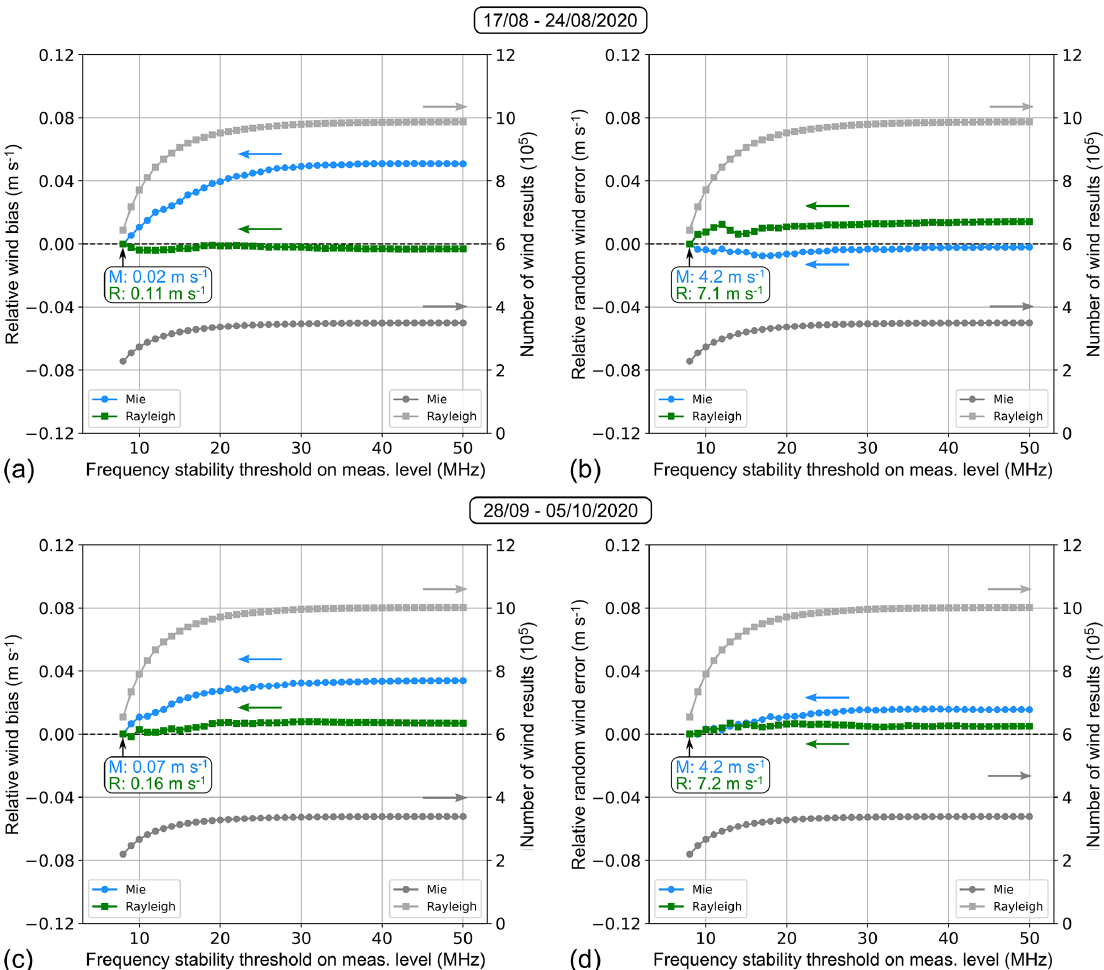
Figure 13. Wind bias (a) and random error (b) of the Mie (blue dots) and the Rayleigh channel (green squares) with respect to the ECMWF model background (O–B) depending on a frequency stability threshold for the period between 17 and 24 August 2020. The bias and random errors were subtracted by the respective values obtained for a threshold of 8MHz for the sake of comparability (see reference values in the boxes). The number of Mie and Rayleigh wind results for which the frequency stability is below the threshold are shown with light-gray dots and dark-gray squares, respectively. Panels (c) and (d) show the corresponding data for the week between 28 September and 5 October